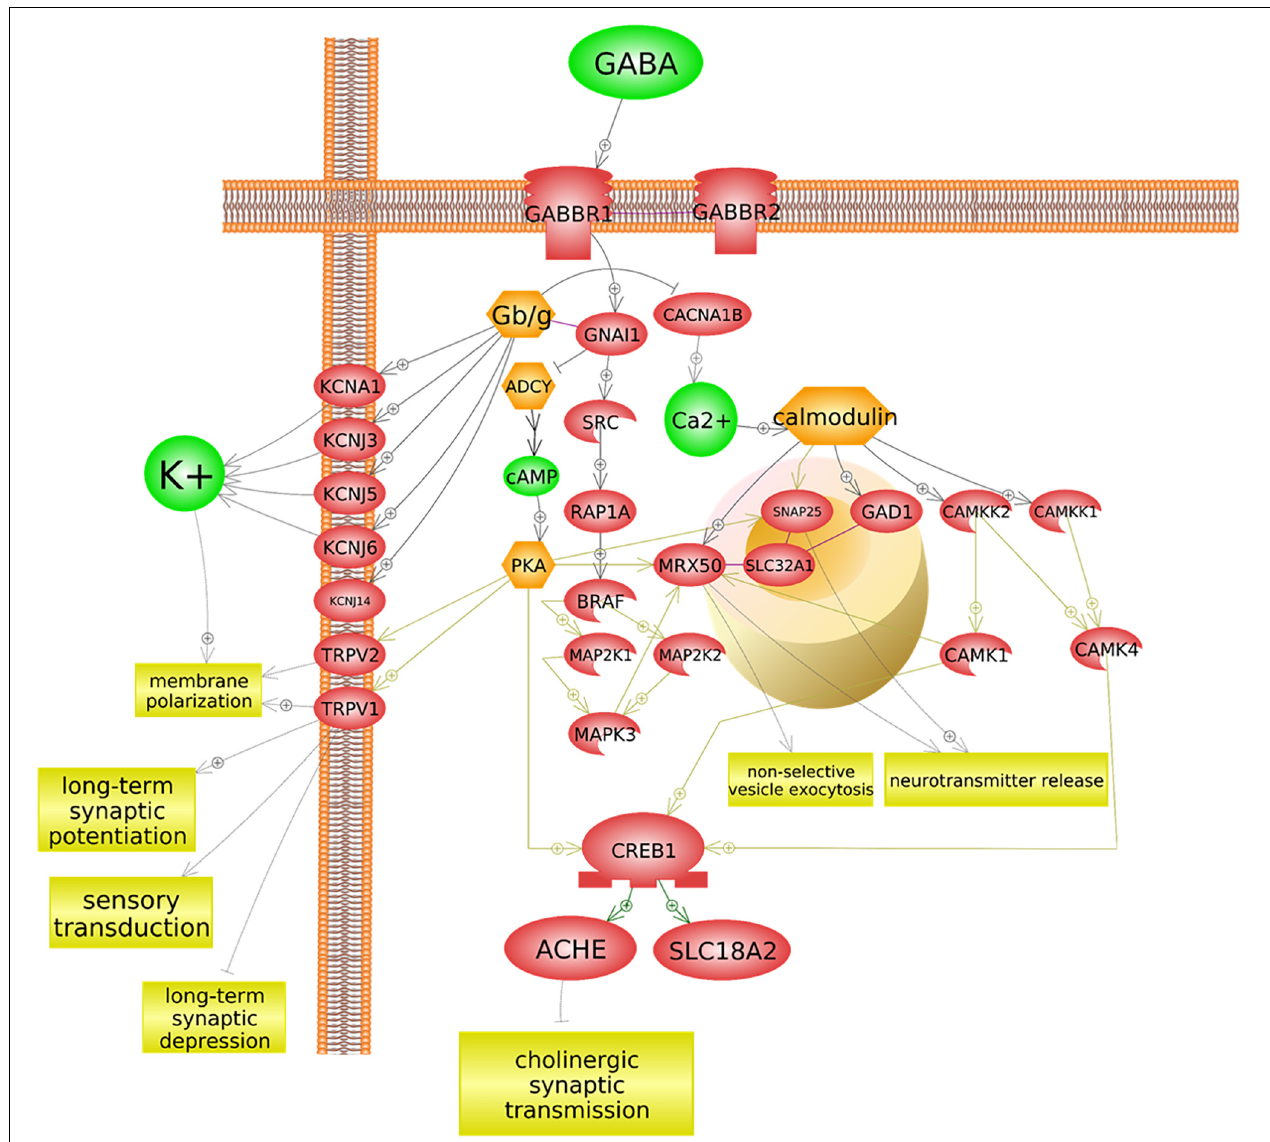
FIGURE 5 | GABBR1 may influence acetylcholinesterase regulation. GABBR1 is an autism-associated gene that codes for a membrane-bound protein (GABA B1 ) (Wu et al., 2020). The binding of the neurotransmitter GABA to GABA B1 has several implications for cholinergic signaling, sensory signal transduction, and ion transport, across multiple cascades. As depicted here, a typical GABA/ GABBR1 binding cascade inhibits adenylyl cyclases (ADCY), thereby preventing positive upregulation of acetylcholinesterase (ACHE). This figure was extracted from Pathway Studio’s curated pathways and was edited according to the needs of this